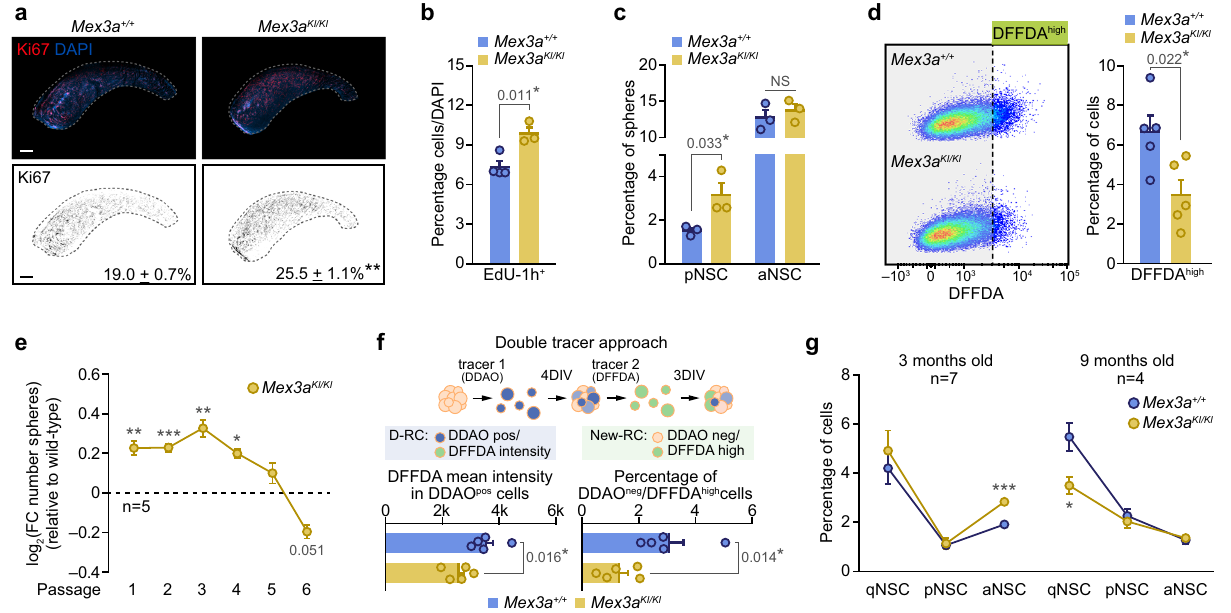
Fig. 4 | MEX3A maintains the balance between cell state transitions and stemnessinNSC.a ImmunohistochemistryforKi67(red)in Mex3a +/+ and Mex3a KI/KI SEZ wholemount preparations (top panels). Binary images of Ki67 (black) for both genotypesandquanti fi cationofthepercentageofKi67 + cellsincoronalsectionsof theSEZ( n =4, p -value=0.003)(bottompanels). b Quanti fi cationofthepercentage ofcellsthatincorporatedEdU1hpriortosacri fi ce(EdU + -1h)intheSEZofwild-type and MEX3A mutant mice. c Quanti fi cation of the percentage of neurospheres ori- ginated fromisolated wild-typeand MEX3A-de fi cientpNSCand aNSC(NS=0.502). d Representative FACS plots of DFFDA staining in wild-type and KI homozygous cultures(left panel). Quanti fi cation ofthe percentage of DFFDA high cells in Mex3a +/+ and Mex3a KI/KI NSC cultures (right panel). e Self-renewal assay in wild-type and MEX3A-de fi cientNSCcultures.Dataisrepresentedasthelog2ofthefold-changein the number ofspheres relative to wild-type for each passage (dashedline)( p -value